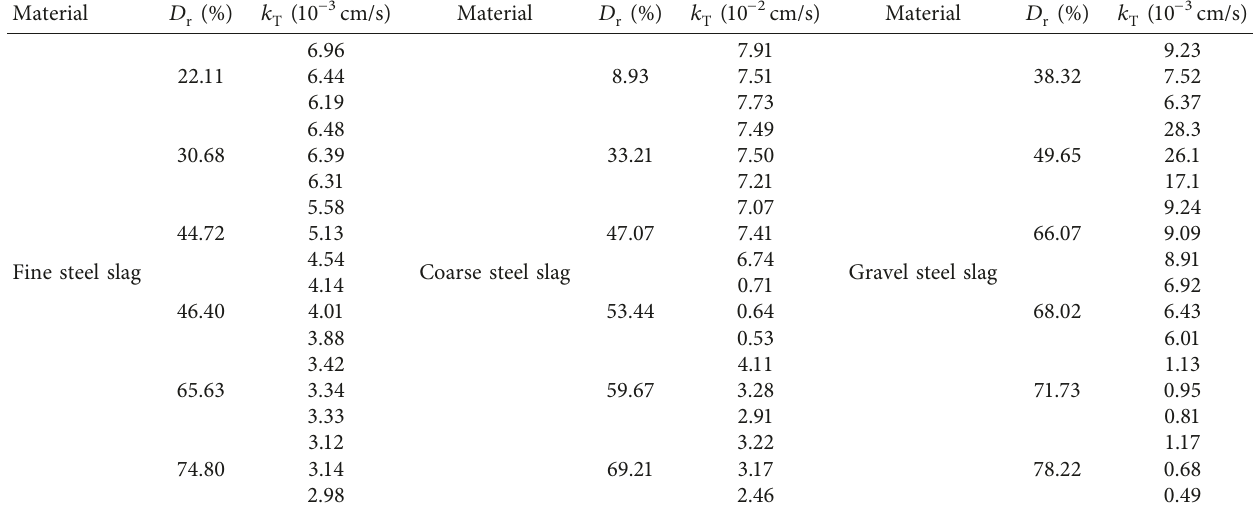
Table 6: Permeability coefficients of parallel experiments under different relative